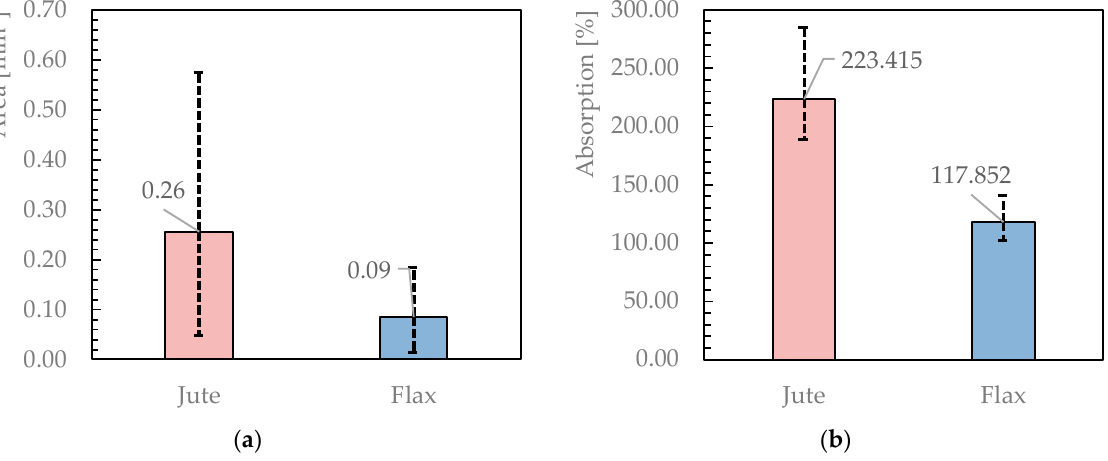
Figure 7. Jute and flax ideal Cross-section ( a ) and Absorption ( b ).